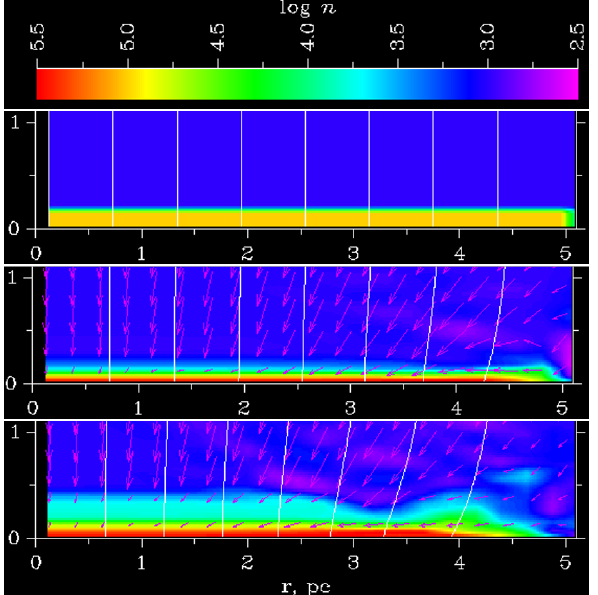
Figure 5. Two-dimensional concentration (color filling) and magnetic field (white isolines) distributions for the adiabatic disk with ini- tially perpendicular magnetic field at t = 0 yrs (initial state, top), t = 9.61 × 10 4 yrs (middle), 1.48 × 10 5 yrs (bottom) after the begin- ning of the collapse.